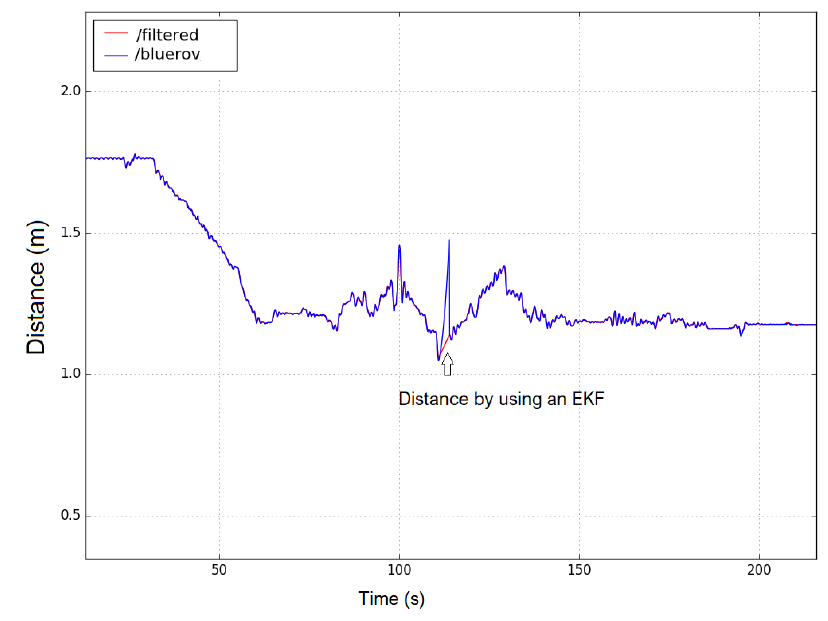
Figure 14. Distance between BlueROV robot follower 1 and the BlueROV robot